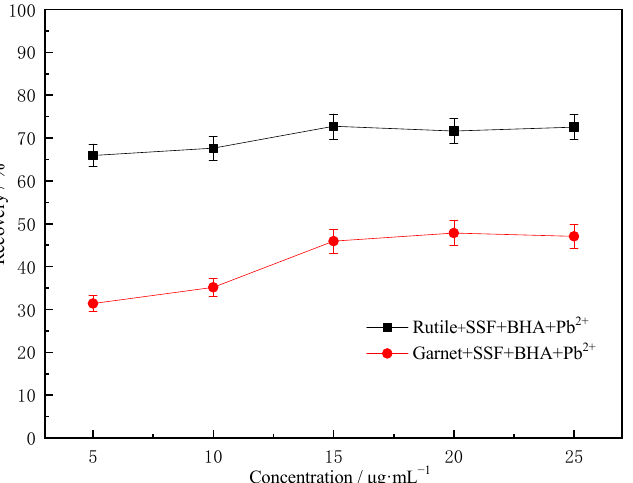
Figure 8. Effect of concentration on Pb 2+ activation of rutile and garnet (pH = 7, concentration of BHA and SSF = 40 mg/L).